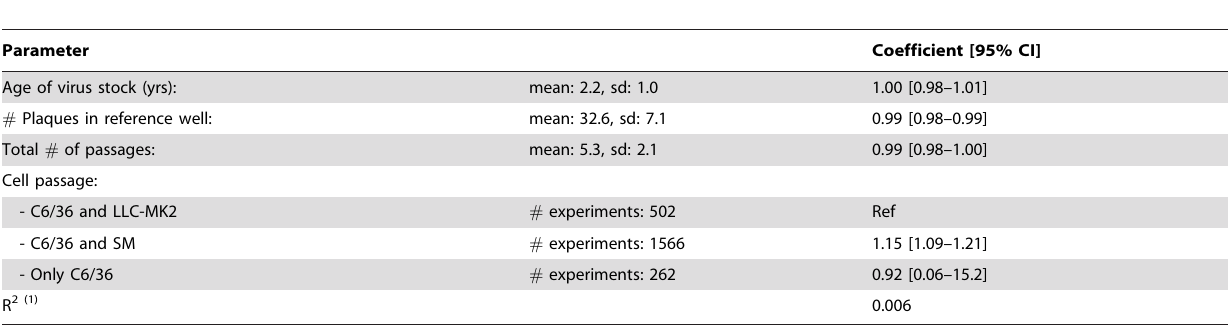
Table 3. Results of multilevel model for impact of experimental factors on PRNT 75 estimates using cloglog regression.